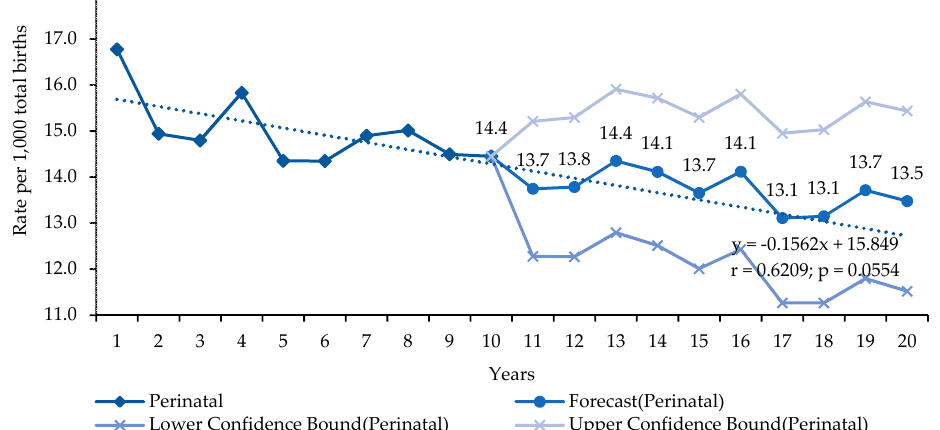
Figure 4. Observed and predicted perinatal mortality and volume balance. Espírito Santo, Brazil, 2008–2017. Source: MS/SVS/CGIAE—Sistema de Informações sobre Mortalidade (SIM) e DASIS—Sistema de Informações sobre Nascidos Vivos (SINASC), 2021.